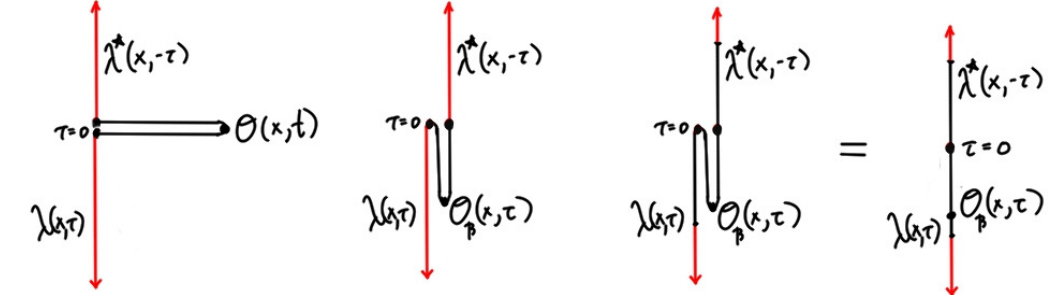
Figure 2 . Path integral contours for evaluation of one point functions in Lorentzian time ((cid:12)rst (cid:12)gure) and Euclidean time (second (cid:12)gure). Red contours indicate where sources have been